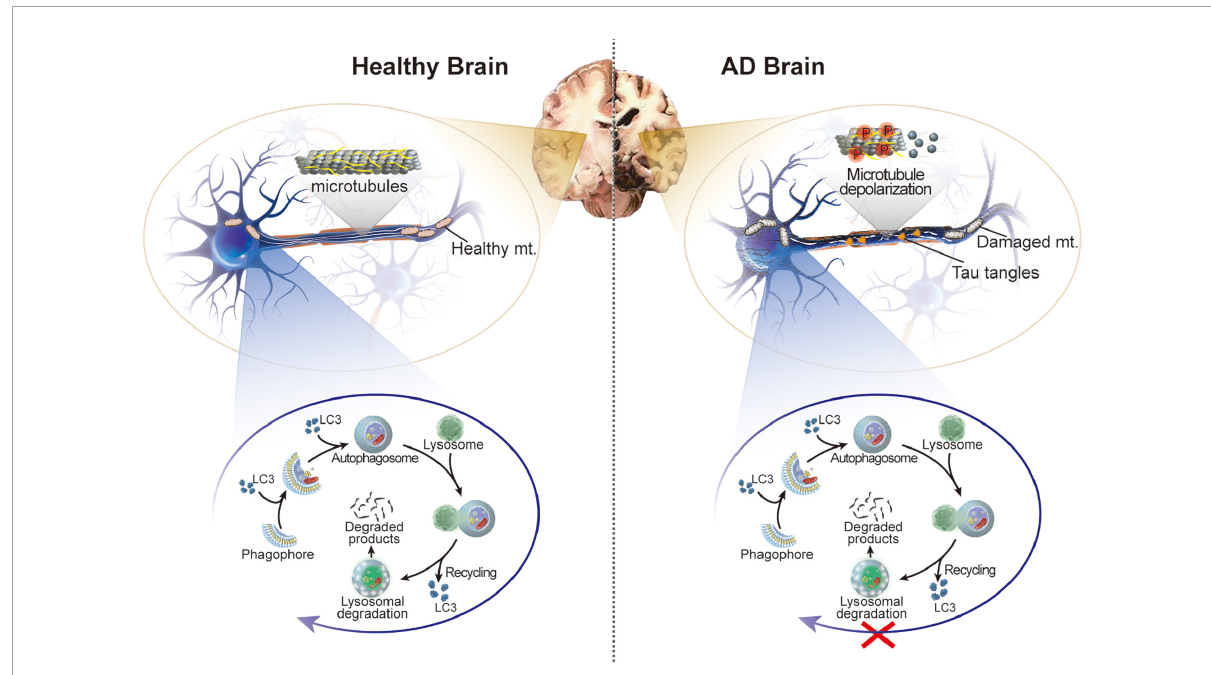
FIGURE1 Schematic illustration of the healthy brain and brain of patients with AD. In AD, hyperphosphorylation of tau protein in neurons leads to microtubule depolarization, aberrant formation of tau tangles, and disruption of several cellular processes accompanied by impaired autophagy and damaged